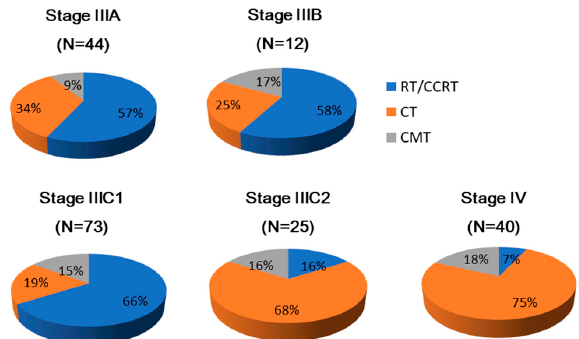
Figure 2. Distribution of adjuvant therapies. The number of patients in each stage is indicated in parentheses. The labels displayed in each chart represent the percentages of patients who received the different adjuvant therapies.